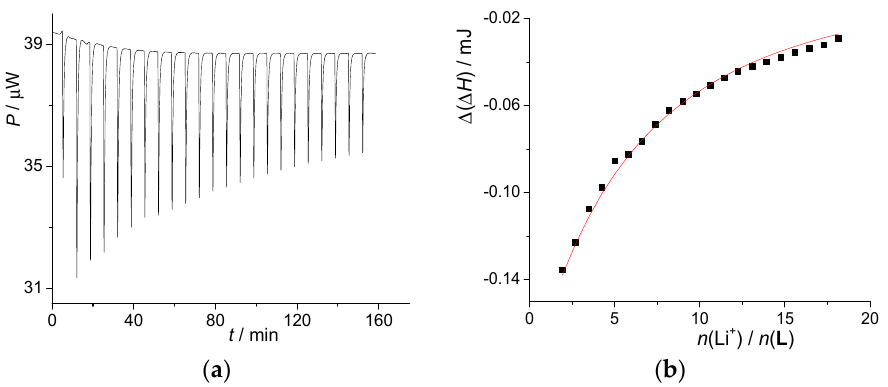
Figure 1. ( a ) Microcalorimetric titration of L ( c = 1.23 × 10 − 4 mol dm − 3 , V = 1.42 mL) with LiClO 4 ( c = 1.45 × 10 − 2 mol dm − 3 ) in methanol at 25 °C; ( b ) dependence of successive enthalpy change on n (LiClO 4 )/ n ( L ) ratio. ■ experimental; ― calculated. Table 1. Thermodynamic parameters for complexation of alkali metal cations with compound L in examined solvents at 25 °C.